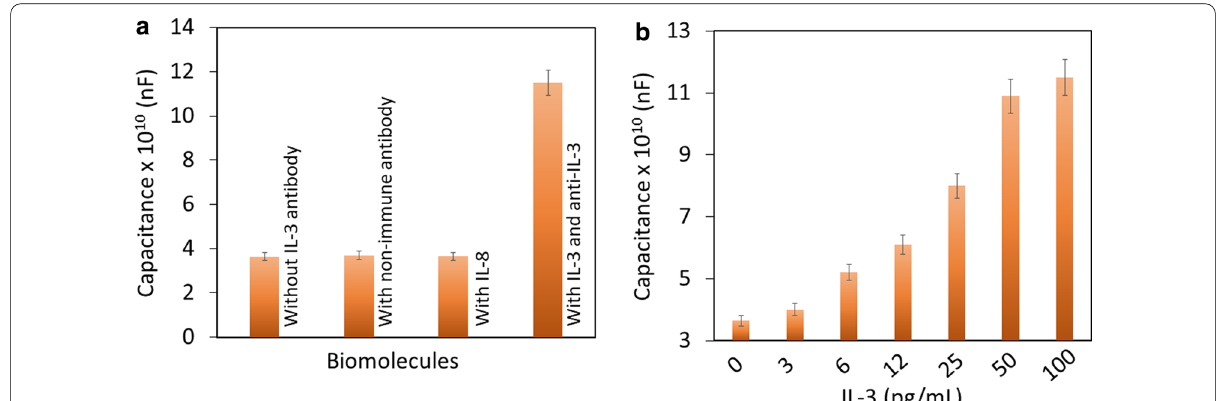
Fig. 6 a Specific detection of IL-3. Control molecules did not show an increase in capacitance value, indicating the specific detection of IL-3. b Spiking of IL-3 in human serum. Spiking in human serum increased the capacitance with increasing IL-3 concentrations. This result confirms the selective detection of IL-3. The values were averaged using three readings as